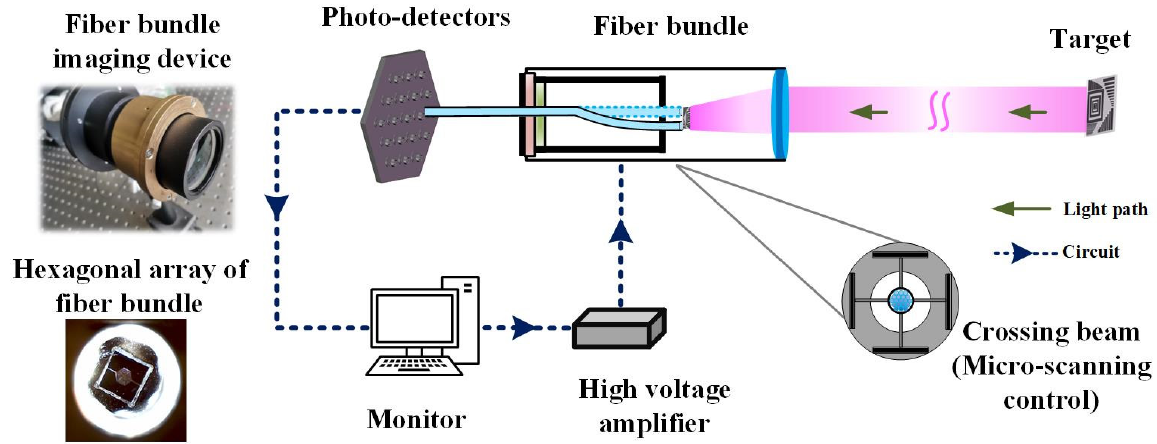
Figure 3. Experimental schematic of high-resolution image based on optical fiber bundles combined with micro-scanning.